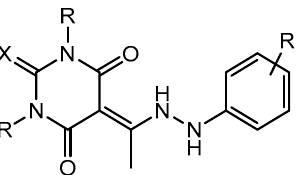
Figure 1. Most promising (thio)barbiturate backbone, from in silico studies, against Mpro and ACE2 proteins.